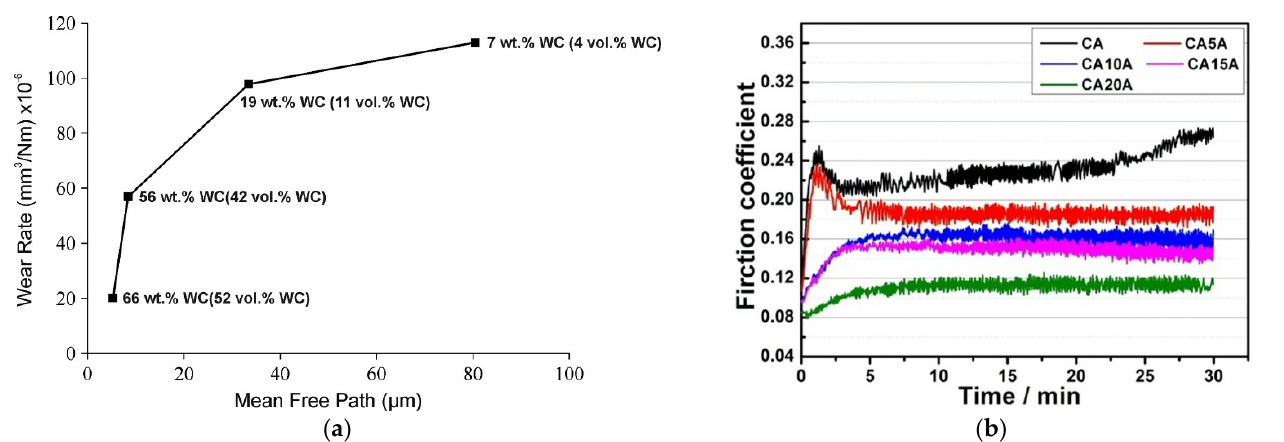
Figure 15. Curve of wear rate versus mean free path for various WC-Ni composite coatings ( a ) (Reprinted with permission from [147]. Copyright 2013 Elsevier. ) and COF curves of (Cu-5Sn)/Al 2 O 3 -Ag coatings with various Ag content (0-20 wt.%) ( b ) (Reprinted with permission from [142]. Copyright 2020 Elsevier).